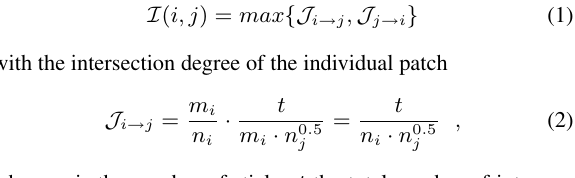
the hypothetical components are “assembled” from arbitrary an- gles into an object. Remote object parts or the patches of concave shapes, as shown in Figure4 (c, d), may not link with some neigh- bors, but still can be included via other object members from a different direction.